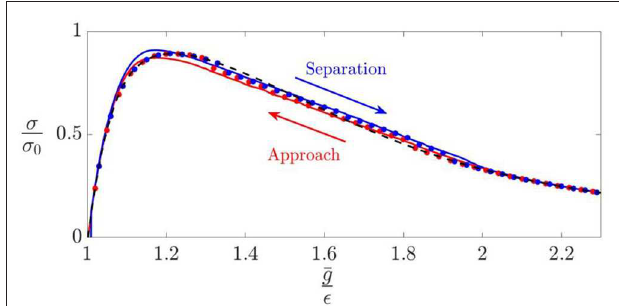
β 0.35, ζ 1 6.5, ζ 2 8.0 and m 0 10 − 1.8 ε 2 . The solid lines correspond to = = = = a direct numerical solution for the rough surface using the Lennard-Jones traction law, whilst the circles were obtained by approximating the effect of roughness through a modified traction law σ M ( g ) ( Joe et al., 2018). [shown here as a dashed line].